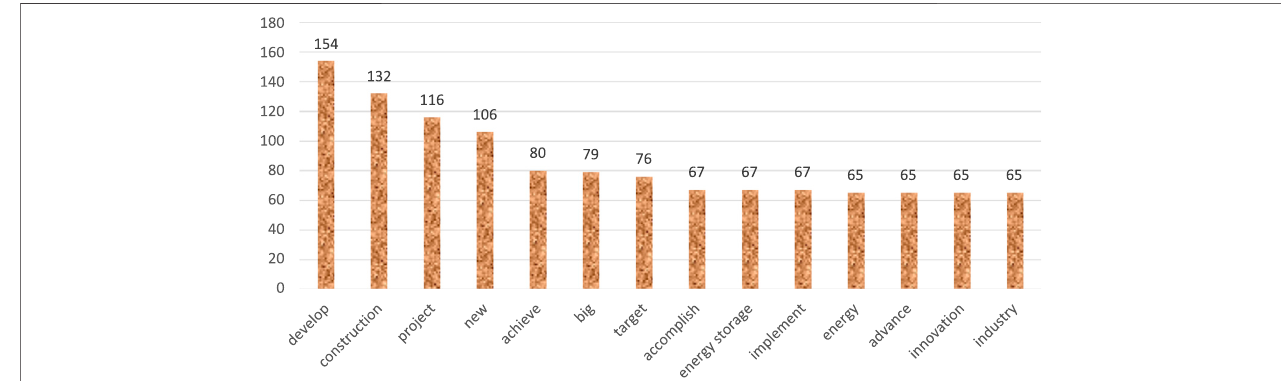
FIGURE 8 | Most mentioned words for “ Carbon neutrality, Targets, and Achieve ” in Weibo microposts.